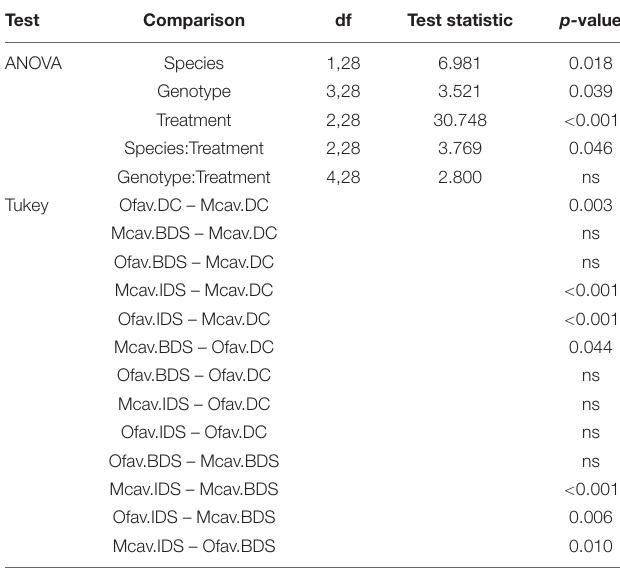
TABLE 2 | Test statistics for comparison of time to SCTLD infection among species and